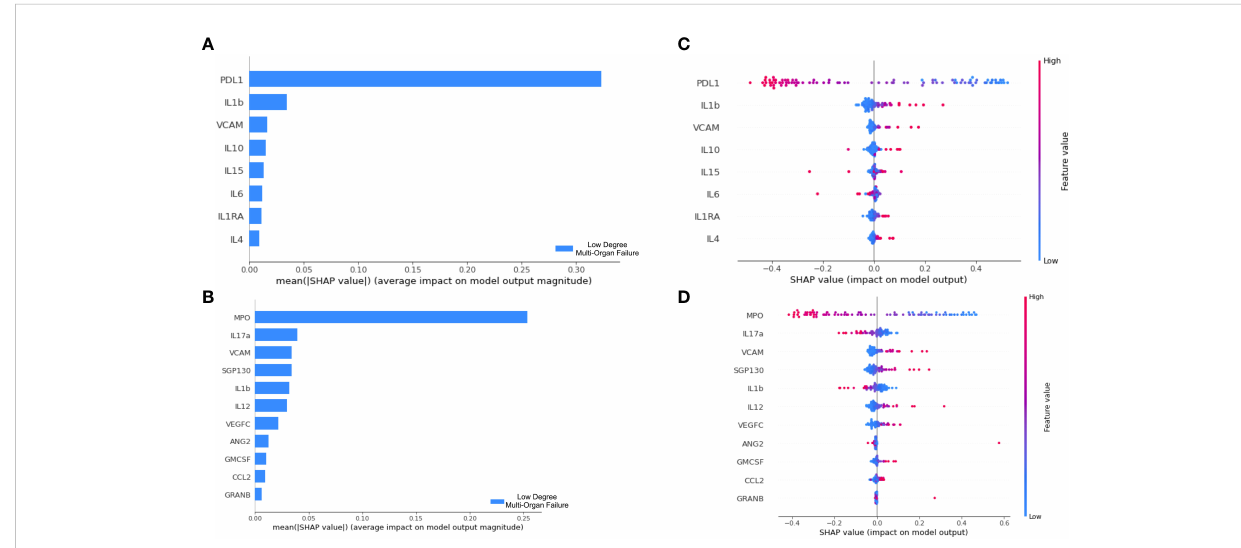
FIGURE 5 Decision pattern of ANNs classifying patients ’ severity with different input biomarkers. The importance of each input biomarker determined by SHAP is displayed in (A, B) for the ANN derived of Boruta and Lasso Regression, respectively. In (C, D) we track the decision of two ANN models in classifying patients. For that, each biomarker is included in the y axis; each patient is represented by a dot in the plot, which has a high or low value corresponding to the biomarker concentration. Finally, the longitudinal location of the dots in the x axis indicates the impact in the SHAP value. Positive SHAP values are used to explain our target class, i.e., LDMOF while negative SHAP values represent the opposite class (i.e., HDMOF).